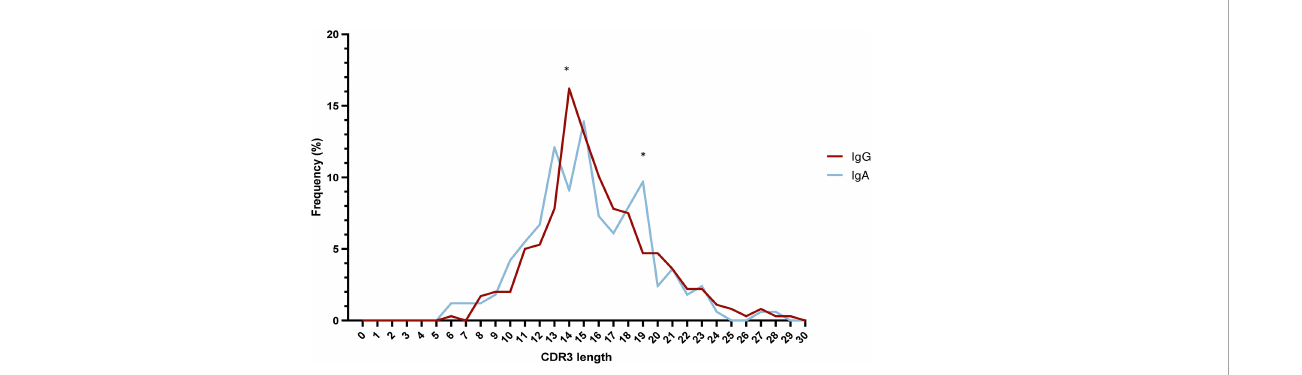
FIGURE 3 Skewed VH CDR3 length distribution in multiple myeloma. Distribution of VH CDR3 length of IgA MM (blue) and IgG MM (red). Signi fi cant differences between the two MM types are observed for VH CDR3 lengths of 14 aa and 19 aa. Asterisks indicate the statistically signi fi cant differences between the two groups (p-value ≤ 0.05 (*)).